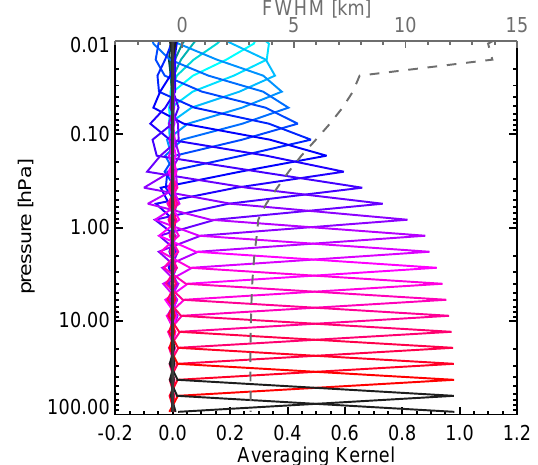
Fig. 16. Averaging kernels for the pT midlatitude day linearisation point (equatorial, midlatitude night, polar summer and polar winter are very similar).The dashed gray line is a measure of the vertical resolution of the retrieved profile (derived from the full width at half maximum (FWHM) of the averaging kernels).